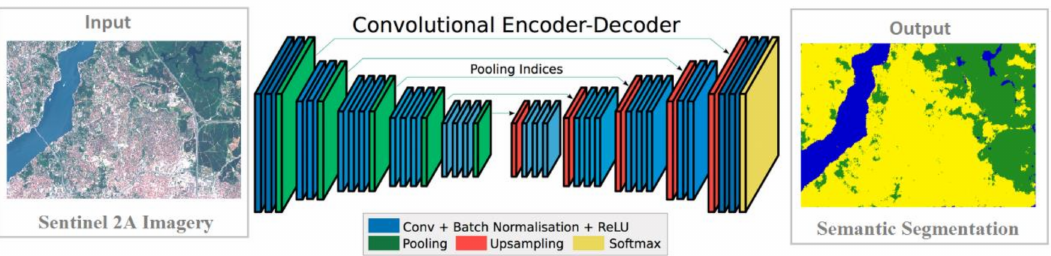
Figure 7. An illustration of the SegNet architecture of our study [27].